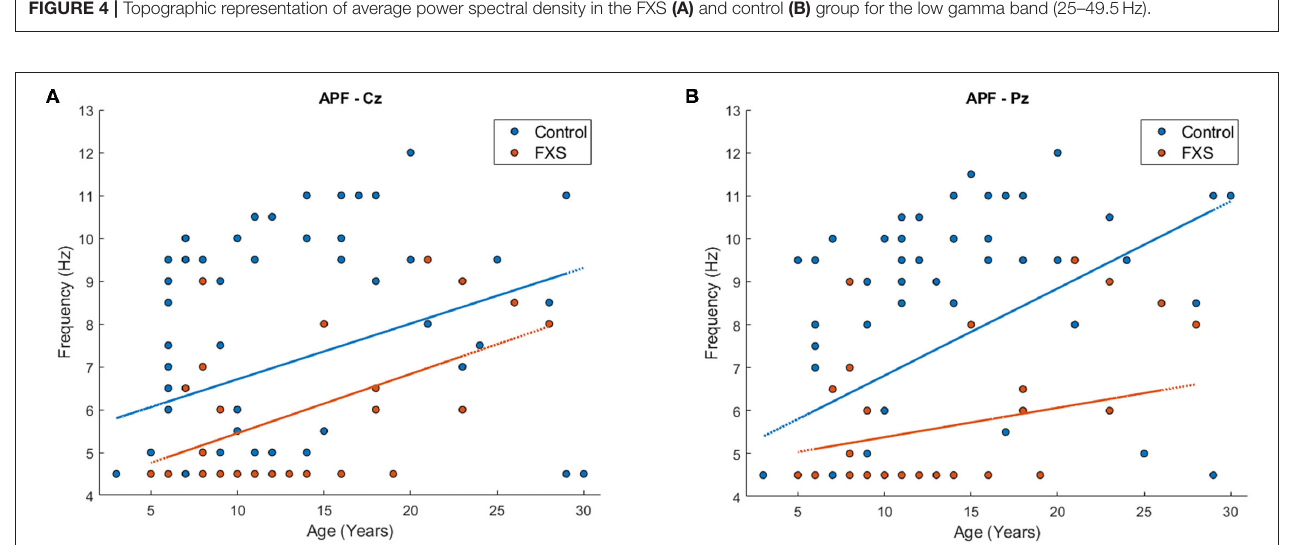
FIGURE 5 | Scatterplot for age and APF for FXS (red) and controls (blue) in region of interest Cz (A) and Pz (B) .